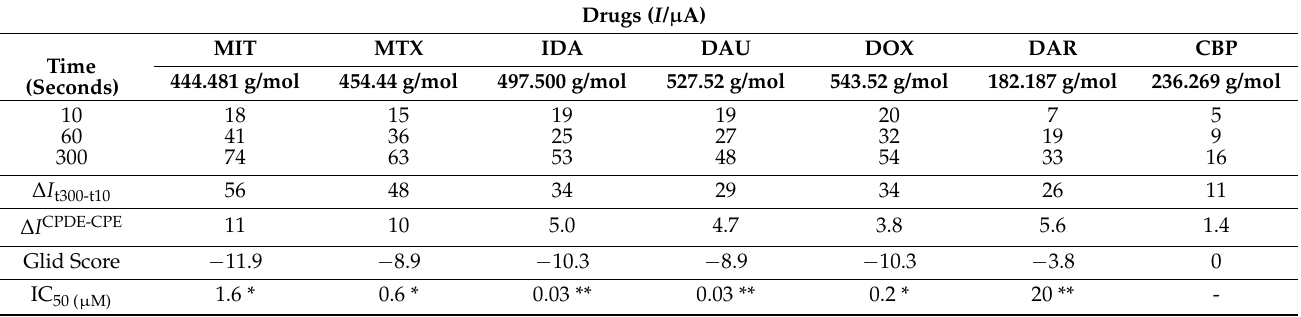
Table 1. Peak current data obtained for CPDE after different immersion times in pH 7.0 0.1 M PBS containing 1 mmol L − 1 , DOX, DAU, IDA, DAR, MIT, and MTX; current increment compared to CPE after 1 min immersion, and the corresponding IC50 values and glid scores for all